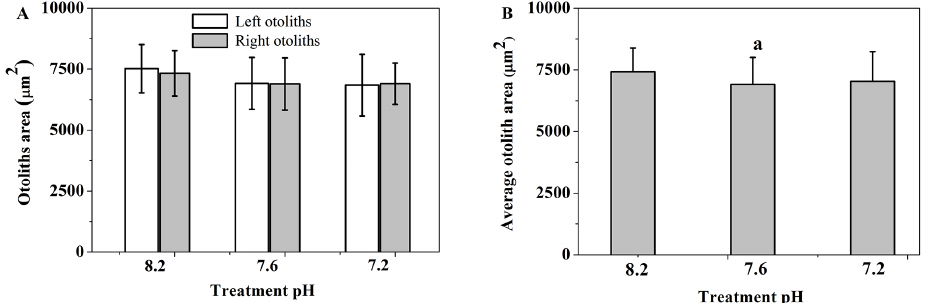
Figure 6. The effects of different pHlevels on the otolith area of marine medaka larvae after 21days of exposure. (a) indicates that the value in pH7.2 or in pH7.6 differs significantly from that in the control